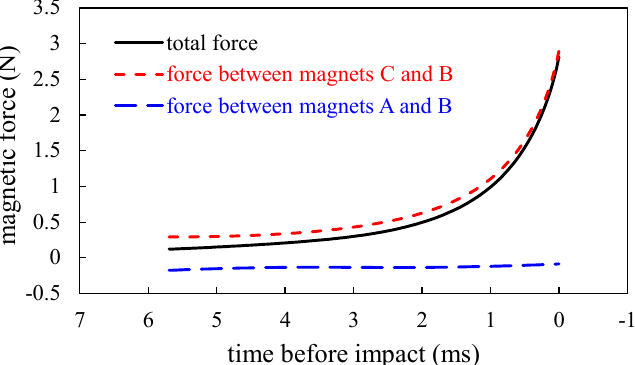
Figure 10. The computed magnetic forces by 3-D magnetic force model before impact.